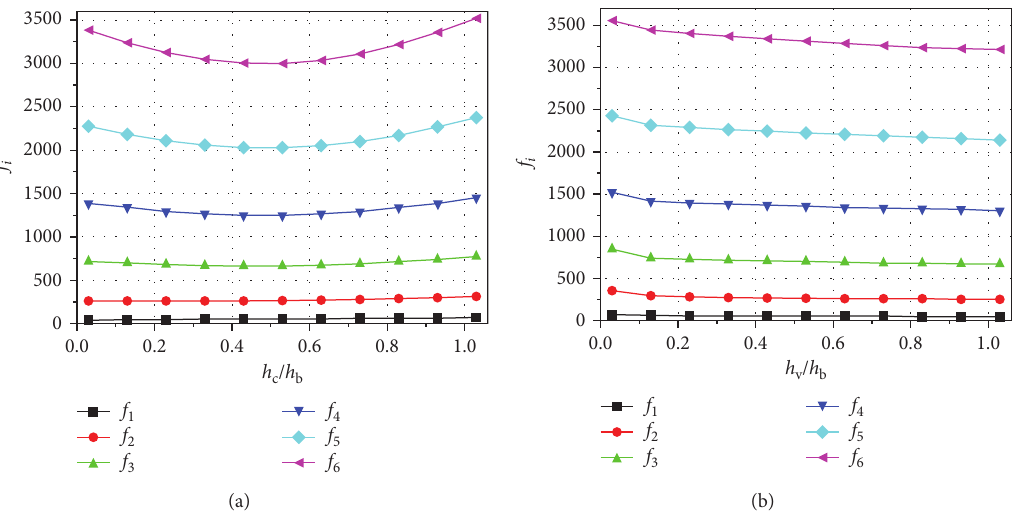
Figure 5: The parameter effects on the first six modal frequencies of structure 1. (a) h